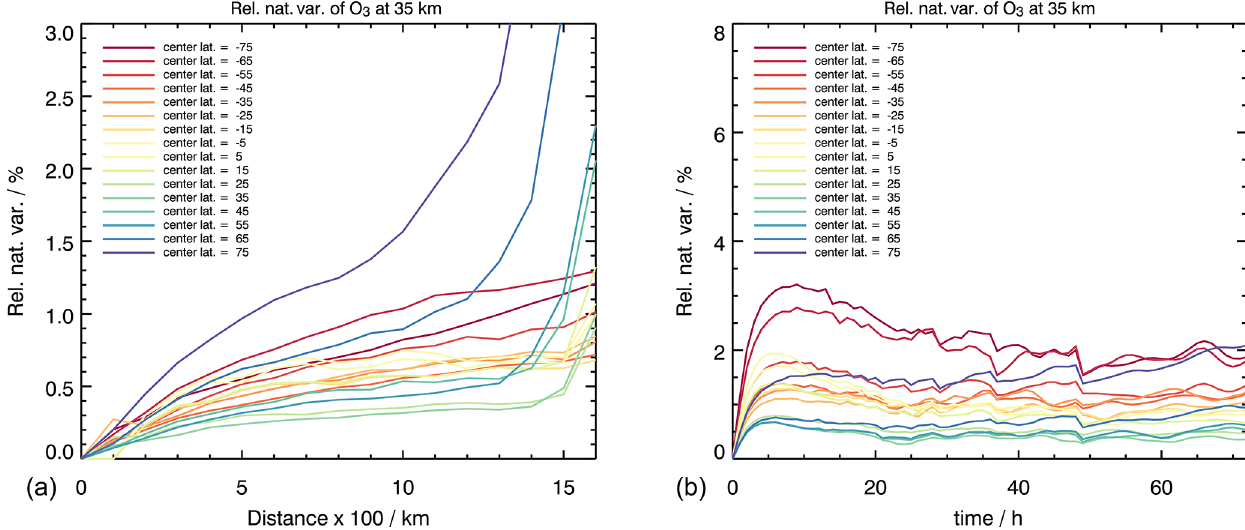
Figure 1. (a) Natural variability of O 3 at 35km altitude as a function of horizontal distance in the BASCOE model. (b) Natural variability of O 3 at 35km altitude as a function of time separation in the BASCOE